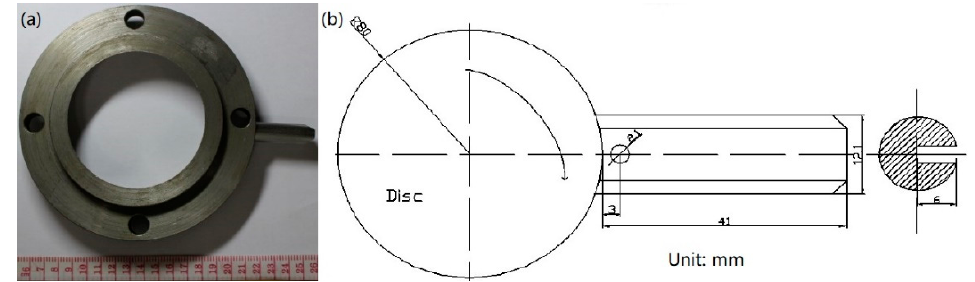
Figure 2. ( a ) Pin and disk specimens; ( b ) shape and size of specimens.